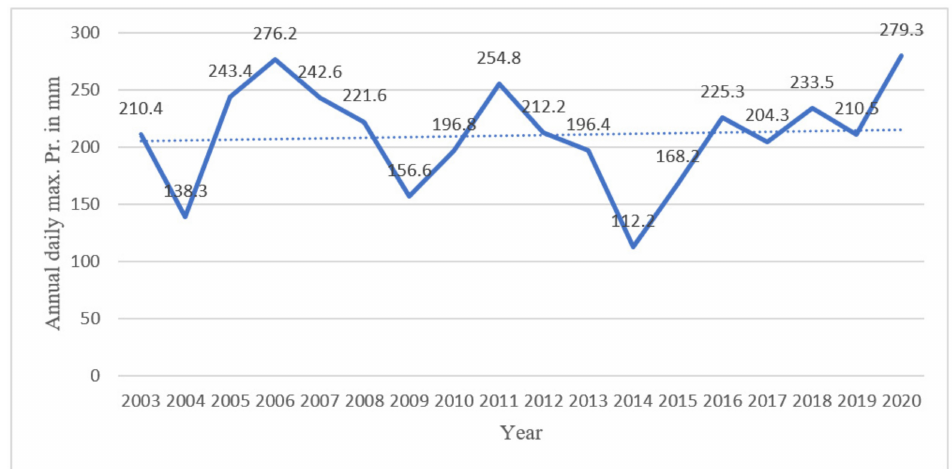
Figure A3. Observed annual daily maximum precipitation of Beluwa Girwari, Nawalpur.